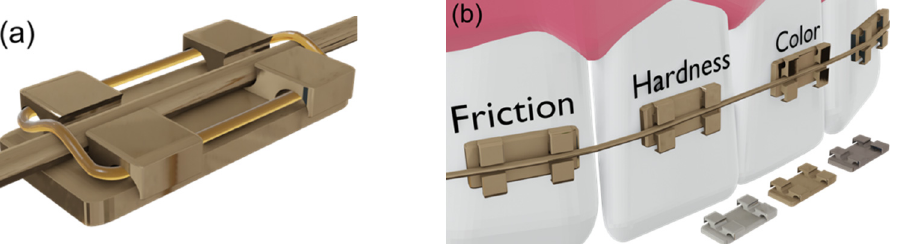
Figure 1. ( a ) Orthodontic brackets, wires, and rubber bands representation. ( b ) The main parameters studied in these systems.